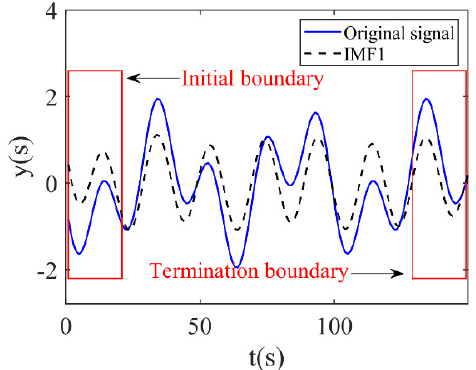
Figure 1. Boundary effect on both sides.